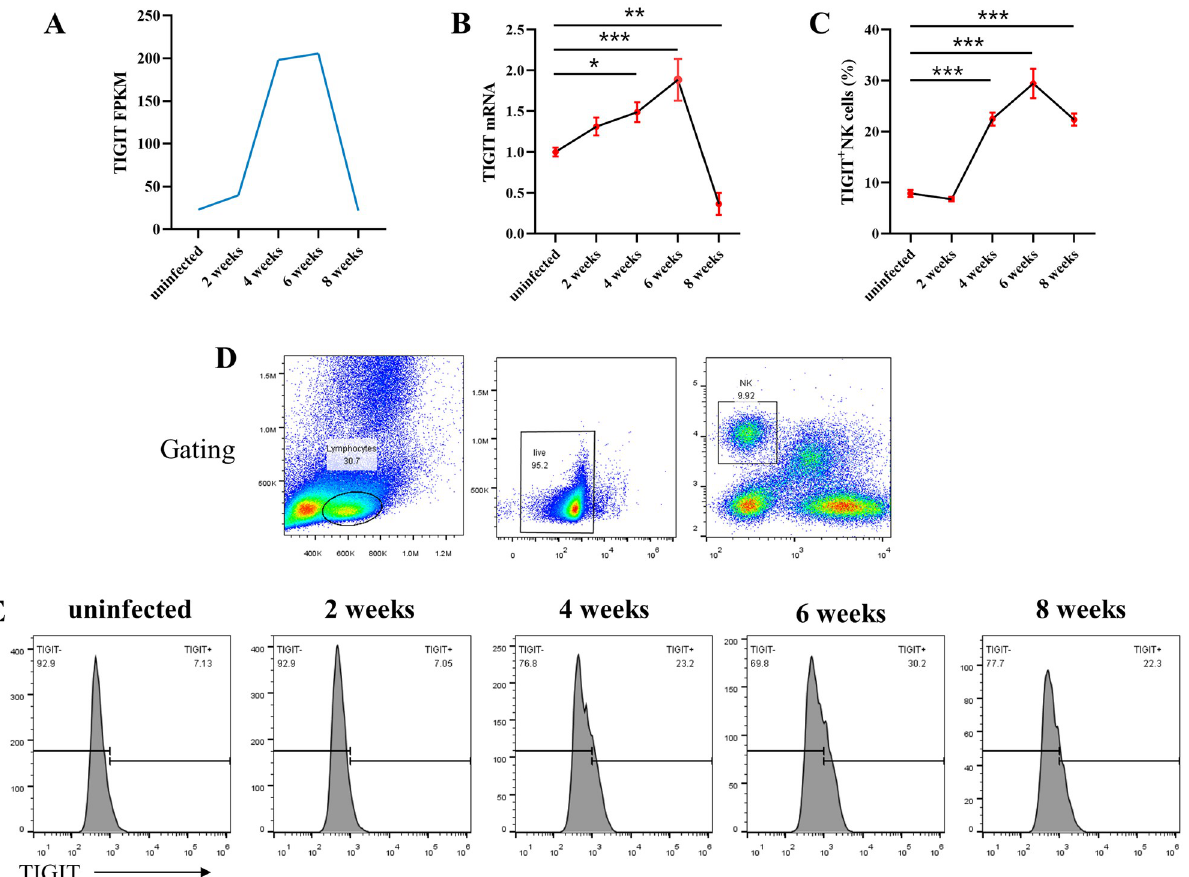
Fig 2. Changes in Tigit expression on hepatic natural killer (NK) cells of mice infected with Schistosoma japonicum . (A) Expression levels of Tigit in hepatic NK cells at different time points after S . japonicum infection (FPKM). (B) Relative mRNA transcript levels of Tigit in hepatic NK cells at different time points after S . japonicum infection. (C) Dynamic changes in the proportion of Tigit + NK cells at different time points after S . japonicum infection. (D) Circle gating strategy of flow cytometry analysis of lymphocytes, viable cells, and NK cells among hepatic non-parenchymal cells. (E) Histogram of the proportion of Tigit + NK cells in the liver at different time points after infection. All data are presented as mean ± standard deviation of at least three independent experiments. � P < 0.05, �� P < 0.01, ��� P < 0.001.